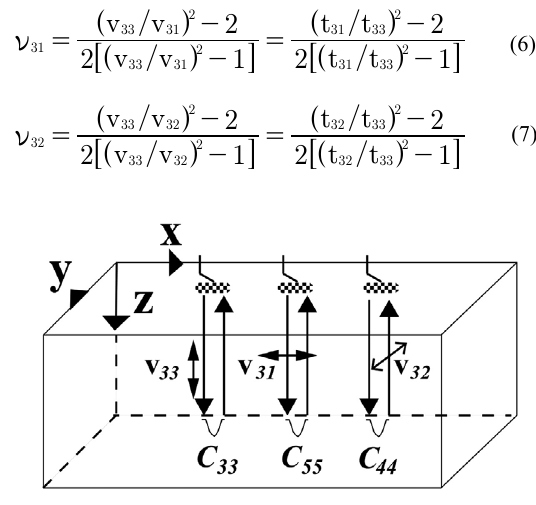
Figure 1. Waves for the determination of elastic constants, with longitudinal and shear waves propagating along z. The longitudinal wave is polarized along the z-axis, while the shear waves of velocities v and v are polarized along the x and y axes, 31 32